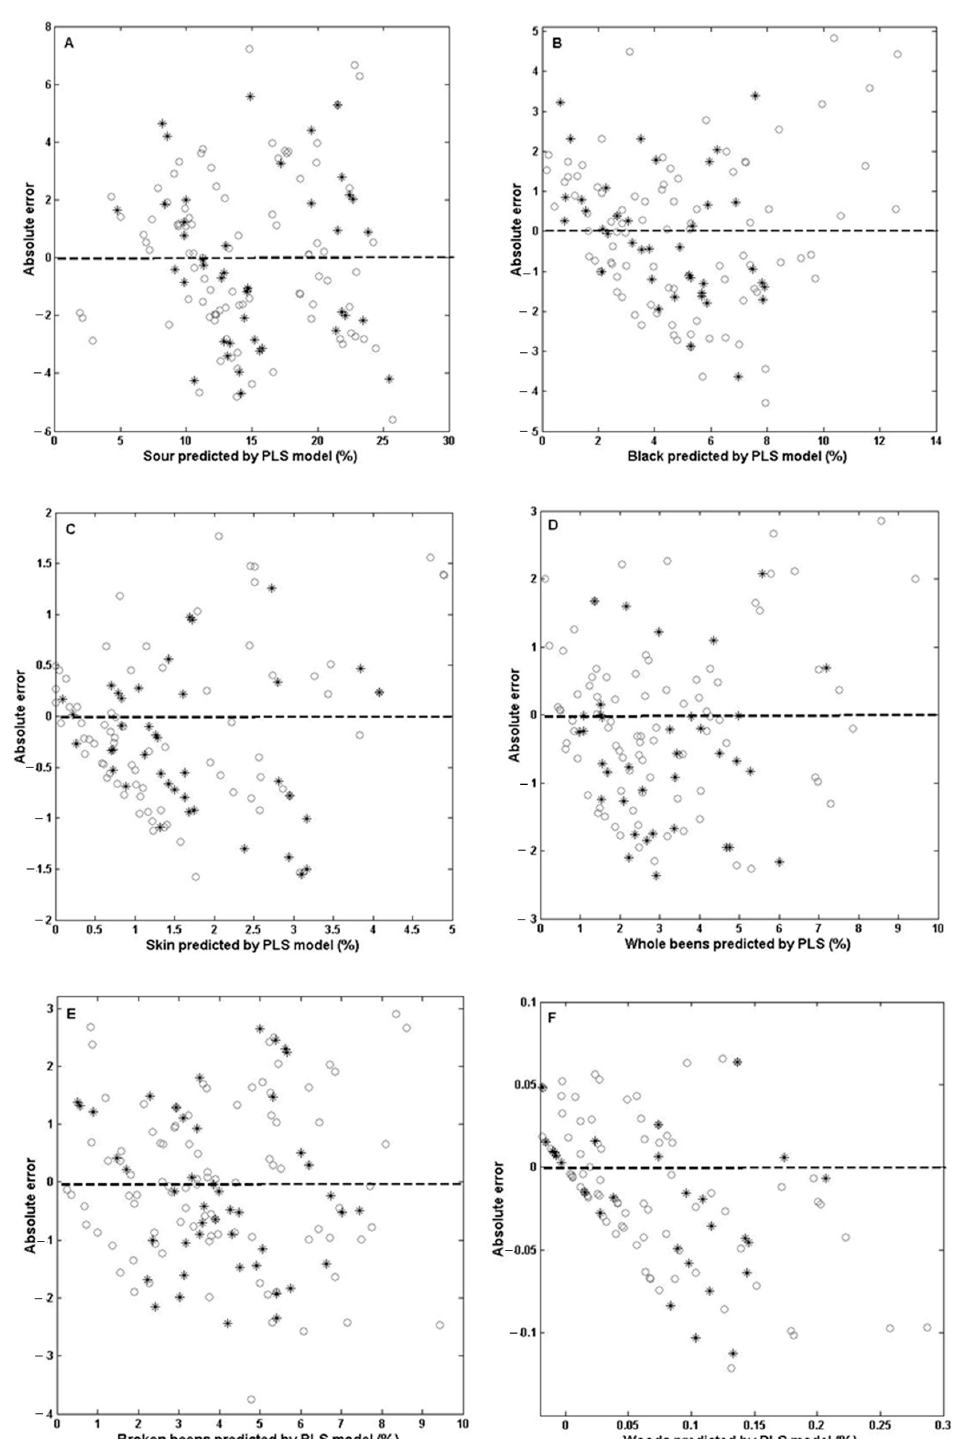
Figure 3. Residuals: ( A ) sour; ( B ) black; ( C ) skin; ( D ) whole; ( E ) broken; ( F ) woods. ( ο ) Calibration samples and ( ∗ ) validation samples.